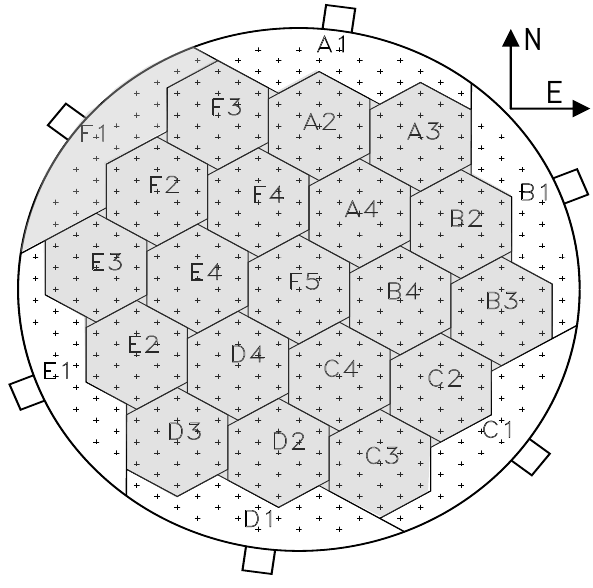
Figure 1. Array configuration of the MUR. Twenty-five antenna groups for transmission/reception are indicated from A1 to F5. The diameter of the array field is about 103 m. The highlighted subarrays, as well as the full array, are employed for reception in the experiment, but the data of F1 subarray are not used in the study.